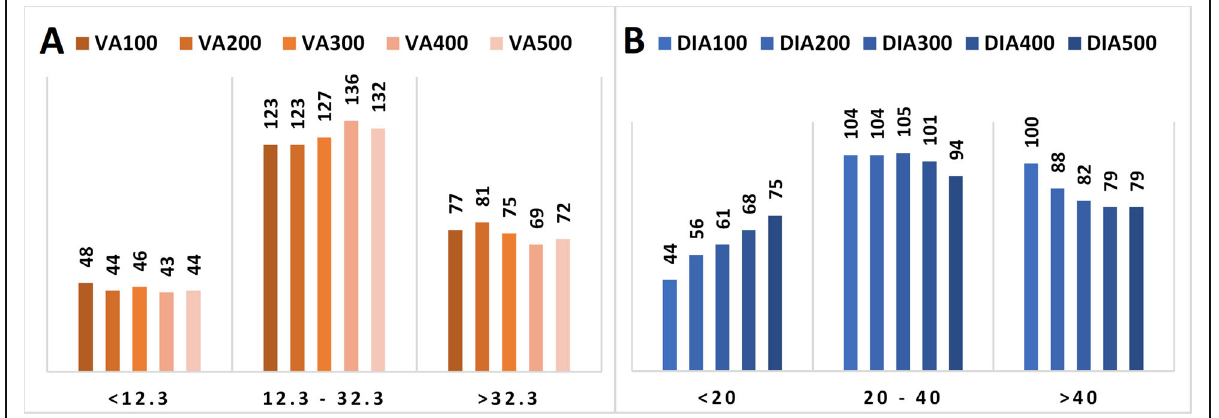
Fig. 6 Number of cases in each Ki-67 category (Low, Intermediate and High) for each 100 cell-increment in A Visual assessment (VA) and B digital image analysis